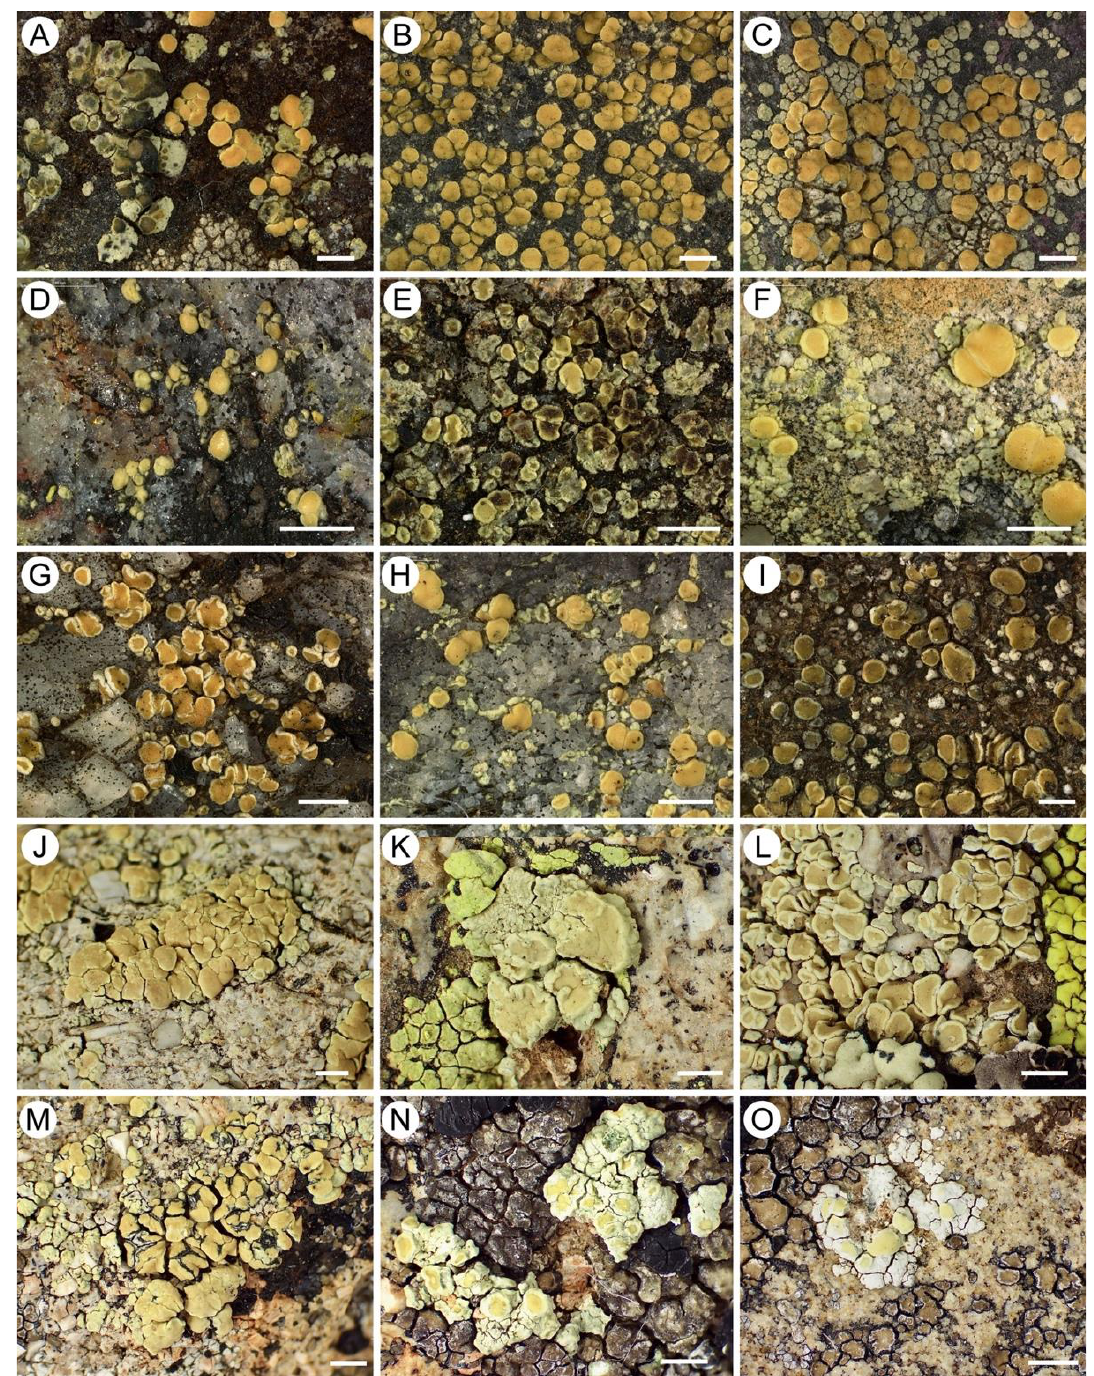
Figure 1. Morphological diversity within the Lecanora polytropa group. ( A ) L. intricata and L. polytropa (McMullin 13834 CANL); ( B ) L. polytropa (McMullin 17629 CANL); ( C ) L. polytropa (McMullin 17695 CANL); ( D ) L. polytropa (McMullin 17811 CANL); ( E ) L. polytropa (McMullin 13266 CANL); ( F ) L. polytropa (McMullin 22536 CANL); ( G ) L. polytropa (McMullin 8820CANL); ( H ) L. polytropa (McMullin 22539 CANL); ( I ) L. polytropa (McMullin 21121 CANL); ( J ) L. polytropa (Leavitt SL18256 BRY-C); ( K ) L. polytropa (Leavitt SL18280 BRY-C); ( L ) L. polytropa (Leavitt SL18356 BRY-C); ( M ) L. polytropa (Leavitt SL18454 BRY-C); ( N ) L. polytropa (Leavitt SL18455 BRY-C); and ( O ) L. polytropa (Leavitt SL18653 BRY-C). Scale bar = 1 mm.